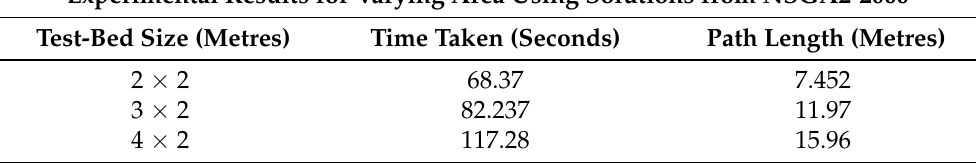
Table 3. Consolidated experimental results for varying